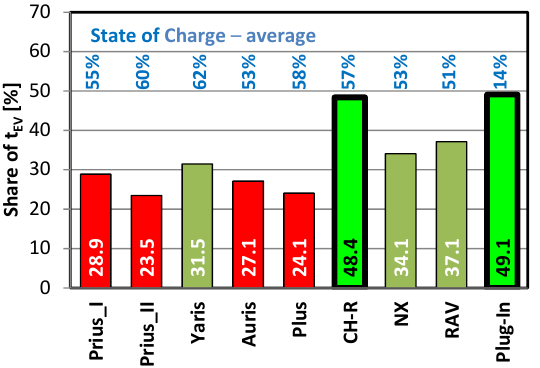
different vehicle weights.